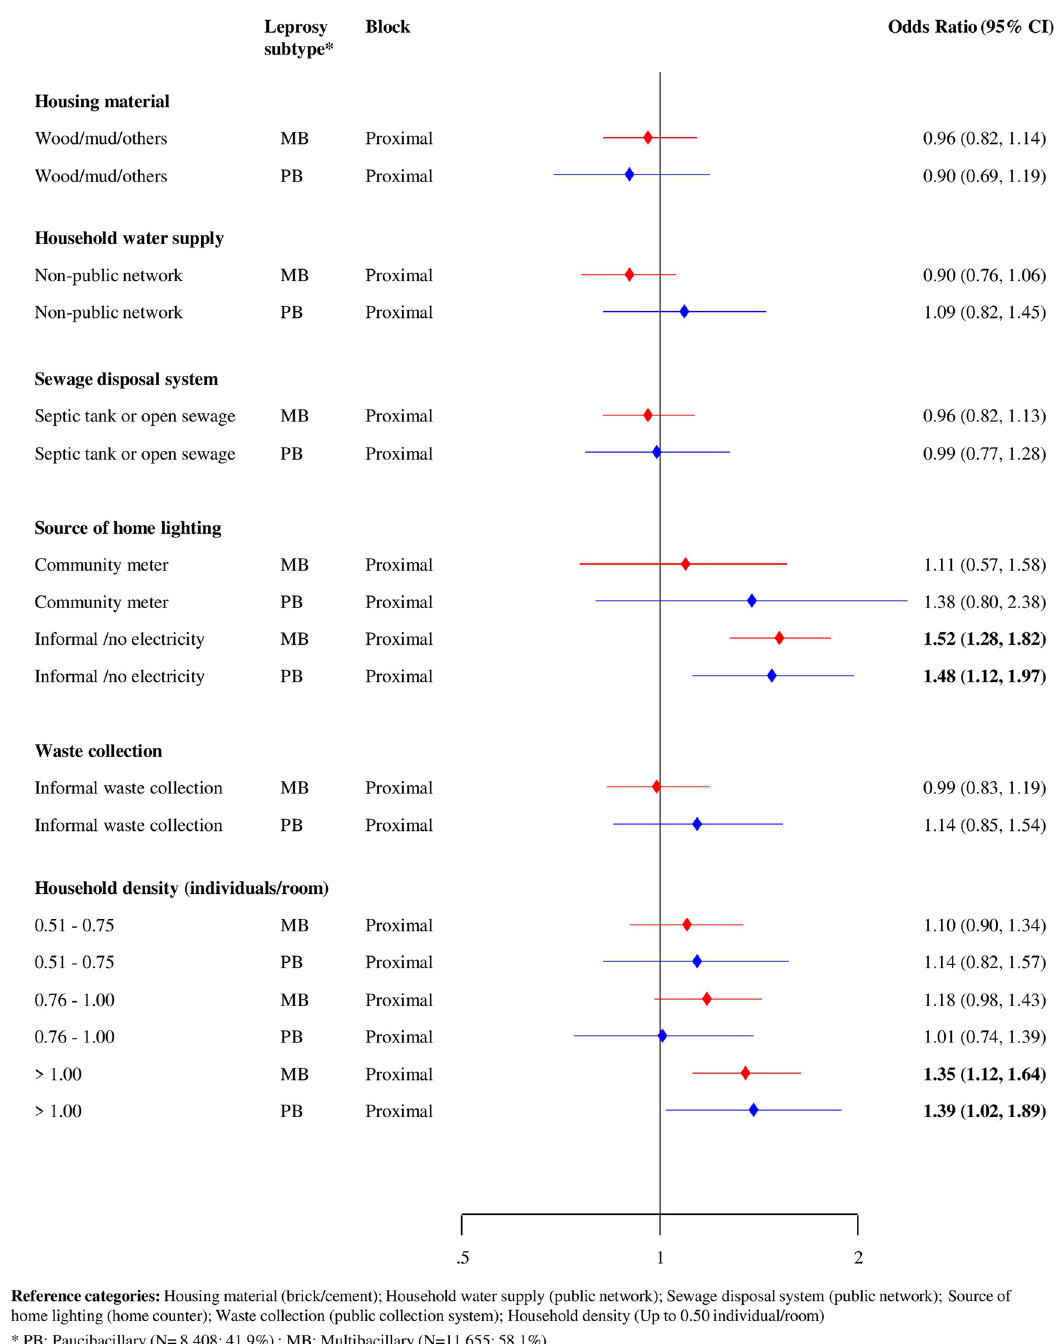
Fig 4. Forest plot of hierarchical association of proximal factors with leprosy treatment default (N = 20,063), stratified by leprosy subtype, Brazil, 2007–2014.